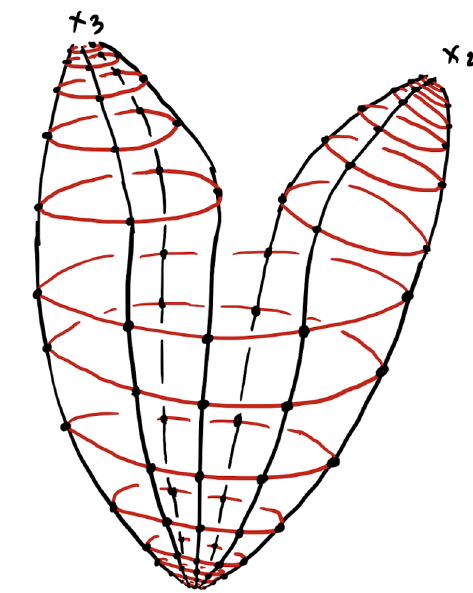
JHEP06(2021)131